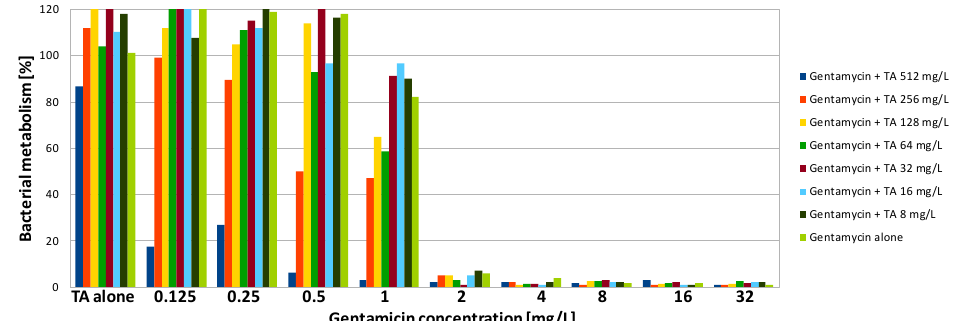
Figure 5. Activity of gentamicin in combination with lipopeptide 2 (L-2) against PA biofilm. Results presented as percentage of metabolic activity in comparison to positive (100%) and negative (0%) controls; RSD ≤ 20%.